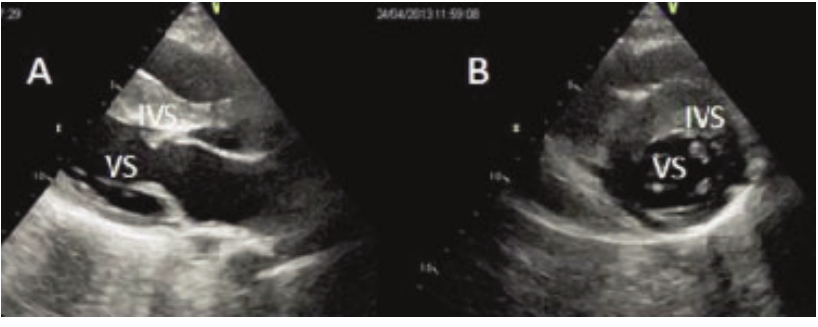
Figure 1. Two-dimensional echocardiographic image of hypertrophic cardiomyopathy in a patient with Costello syndrome with evidence in the long axis (A) and short axis